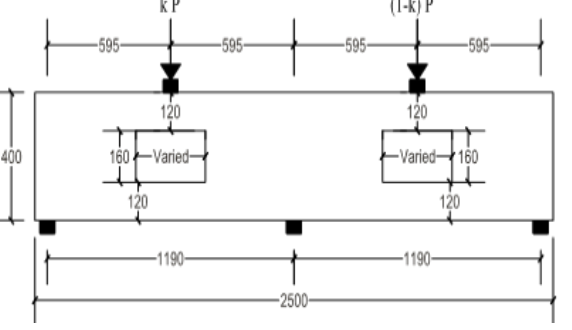
Figure 17. Typical layout of the RCCDBs with openings to consider the load distribution factor. Table 8. Effects of the load distribution factor on the FE ultimate capacities and mid-span deflections. Distribution Load Specimen Opening Ratio Factor